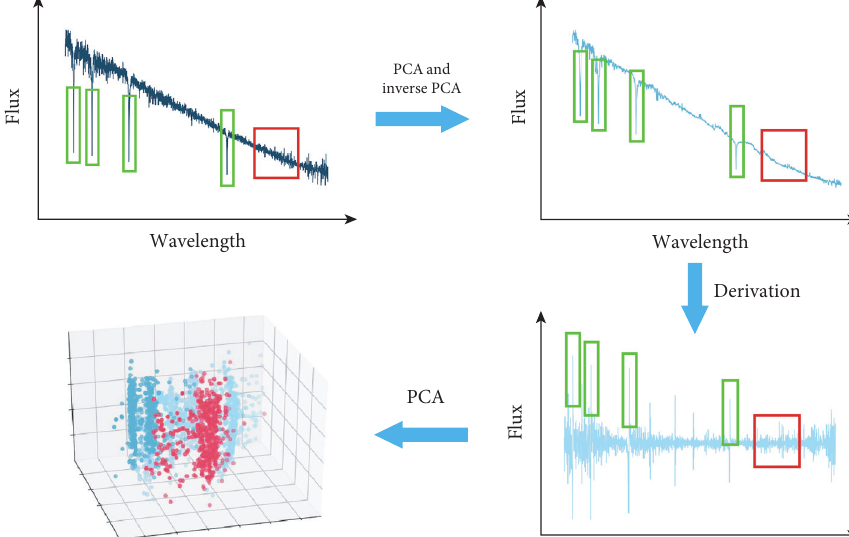
Figure 3: Partial features’ extraction process.